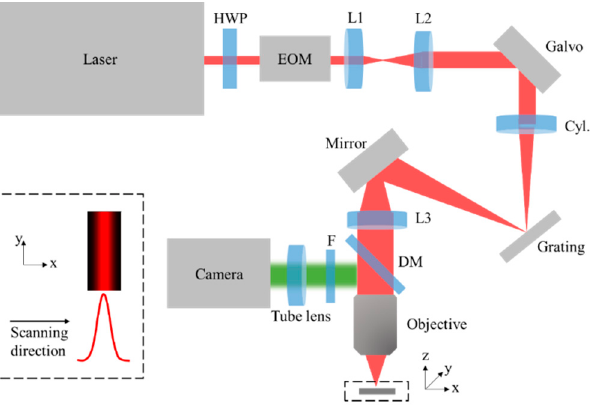
Figure 1. Optical setup of the HiLo-LSTFM. HWP: half wave plate. EOM: electro-optical modulator. L1: lens 1, f = 60 mm. L2: lens 2, f = 150 mm. Cyl.: cylinder lens, f = 300 mm. L3: lens 3, f = 200 mm. DM: dichroic mirror. F: filter. Tube lens, f = 200 mm. The insert shows that, at the focal plane, the excitation laser is shaped into a spatio-temporal focusing line with Gaussian distribution along the lateral scanning direction.